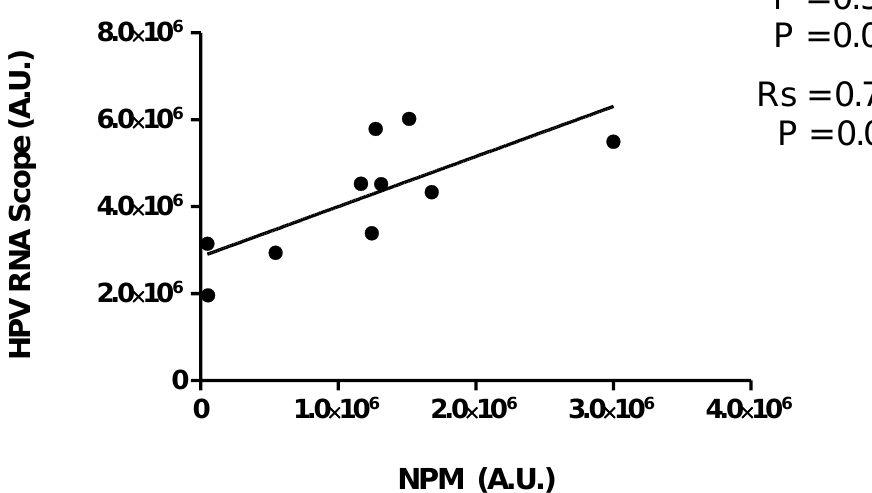
Figure 3. Correlation analysis and linear regression between NPM levels and mRNA HR-HPV expression in OPCCS. Spearman correlation analysis (Rs) and linear regression (r 2 ) between NPM IHC positivity and mRNA HR-HPV ISH levels. IHC quantification of NPM and E6/E7 mRNA HR-HPV ISH were quantified by Image J color deconvolution of three adjacent fields for each section and transformed in arbitrary units (A.U.) of positivity for each